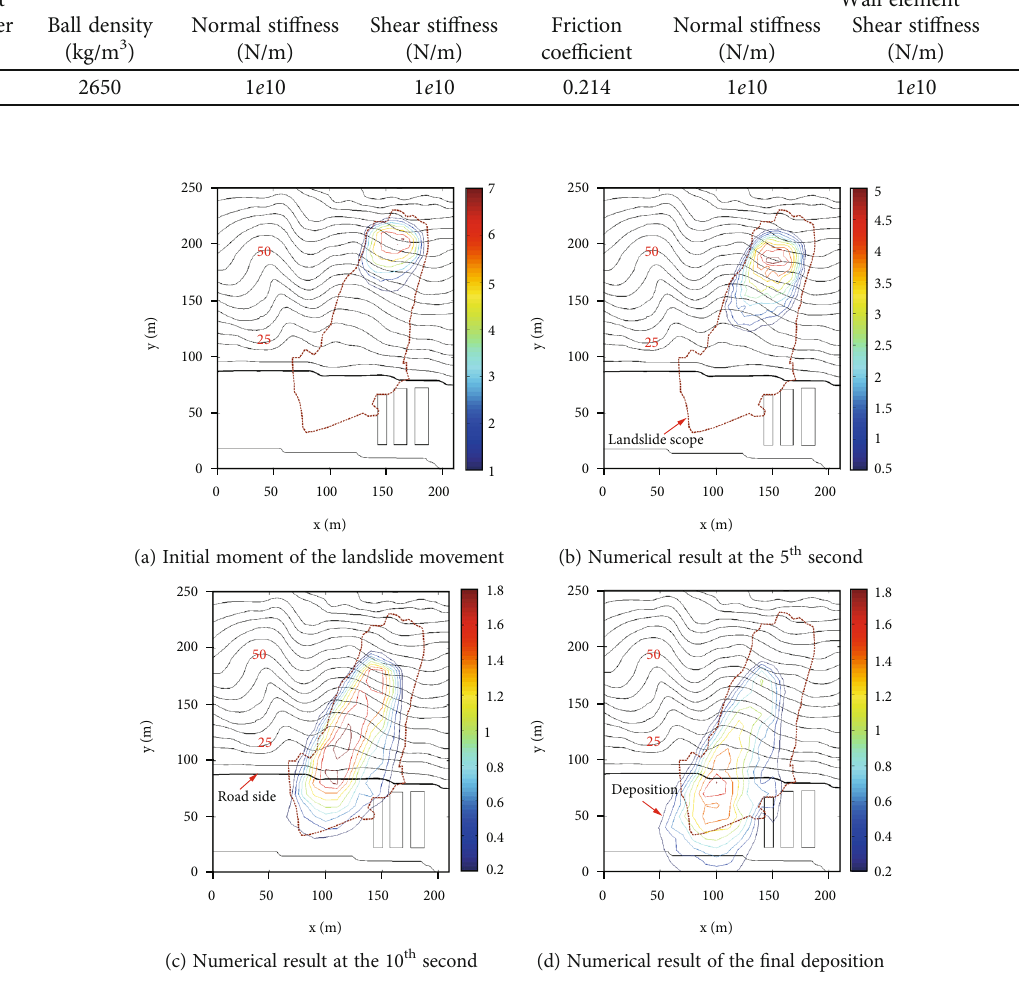
Figure 4: Flow depth contour map of the Shum Wan Road landslide (m).